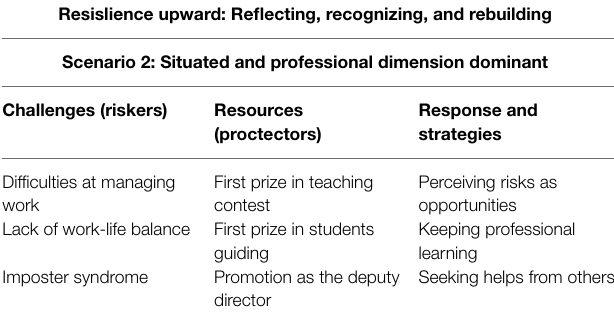
TABLE 2 | Summary of variables in LN’s resilience-building phase 2 (8–9th years). Resislience upward: Reflecting, recognizing, and